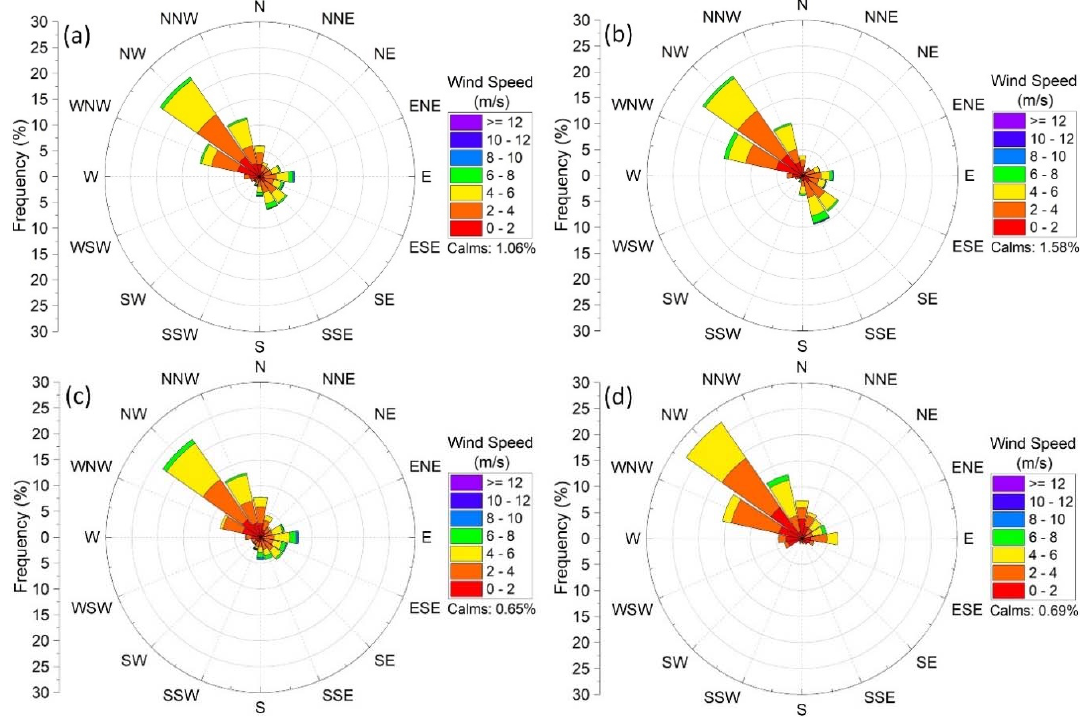
Figure 2. Wind ‐ rose plots of the study area during ( a ) the entire study, ( b ) pre ‐ lockdown (Pre ‐ LD), ( c ) Figure 2. Wind-rose plots of the study area during ( a ) the entire study, ( b ) pre-lockdown (Pre-LD), lockdown (LD), and ( d ) post ‐ lockdown (Post ‐ LD) periods. ( c ) lockdown (LD), and ( d ) post-lockdown (Post-LD)